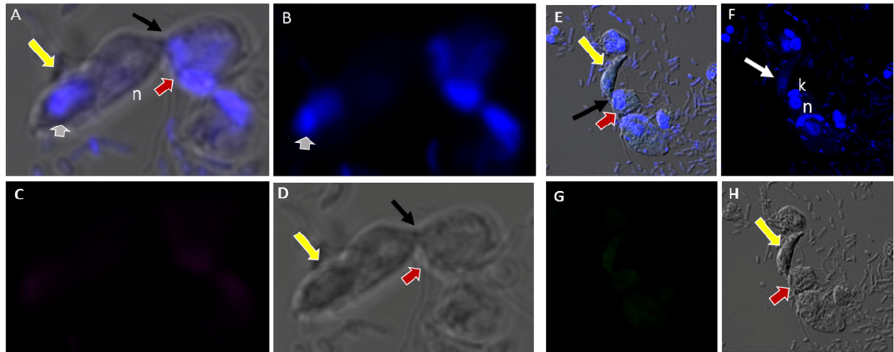
observed on some P. caudatus trophozoites.